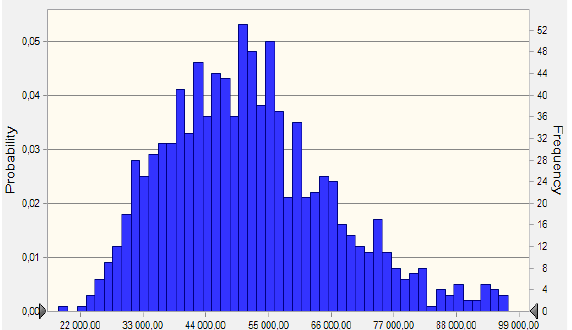
Figure 10. Probability distributions of the present value of incomes from the accommodation rental facilities for 10 years in Košice. facilities for 10 years in